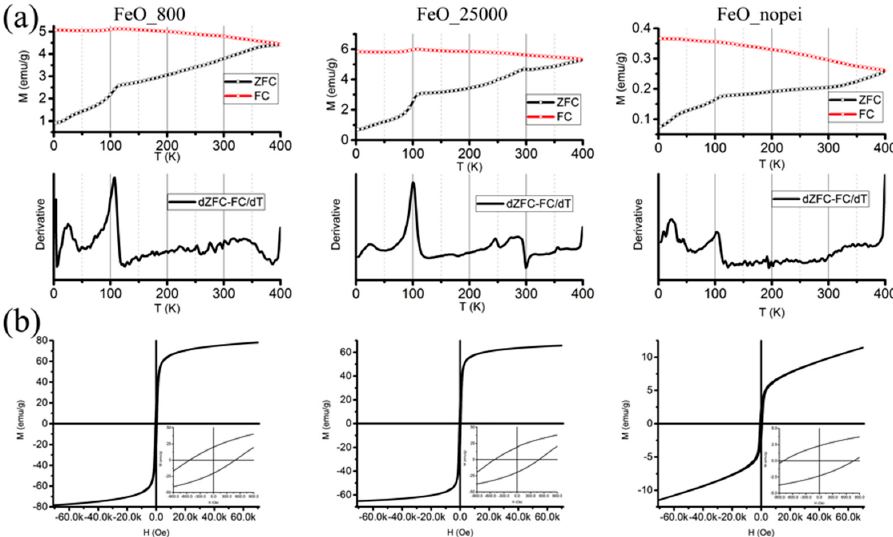
Figure 5. Zero-field-cooled and field-cooled (ZFC–FC) magnetization curves and derivative d(ZFC–FC)/dT curves ( a ) and hysteresis loops recorded at 4 K ( b ) for the FeO_800, FeO_25000, and